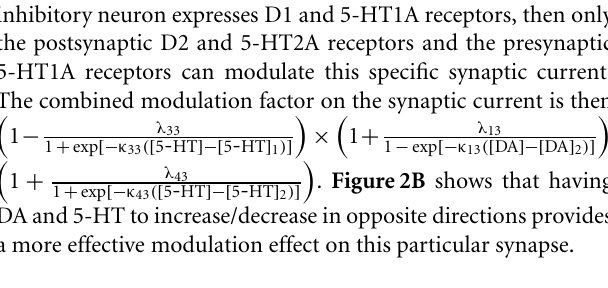
Frontiers in Integrative Neuroscience